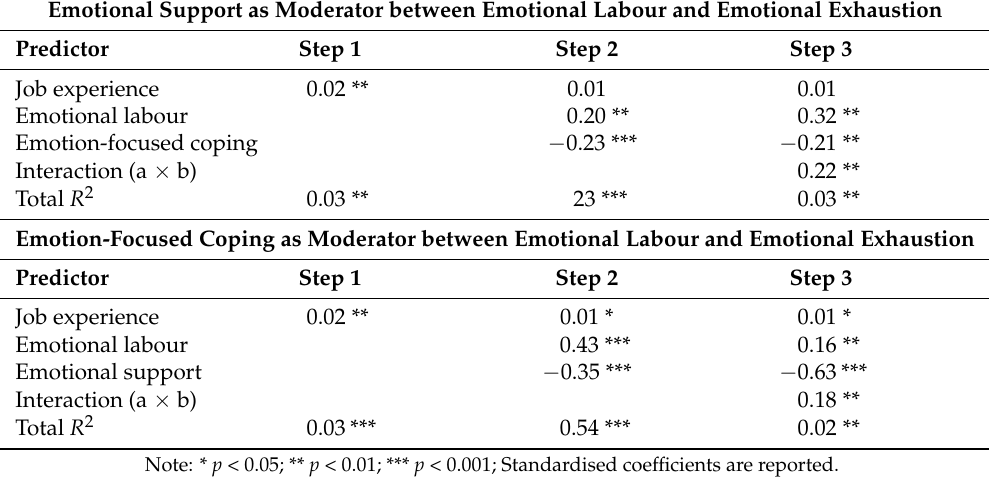
Table 2. Moderating effects of emotional support and emotion-focused coping.